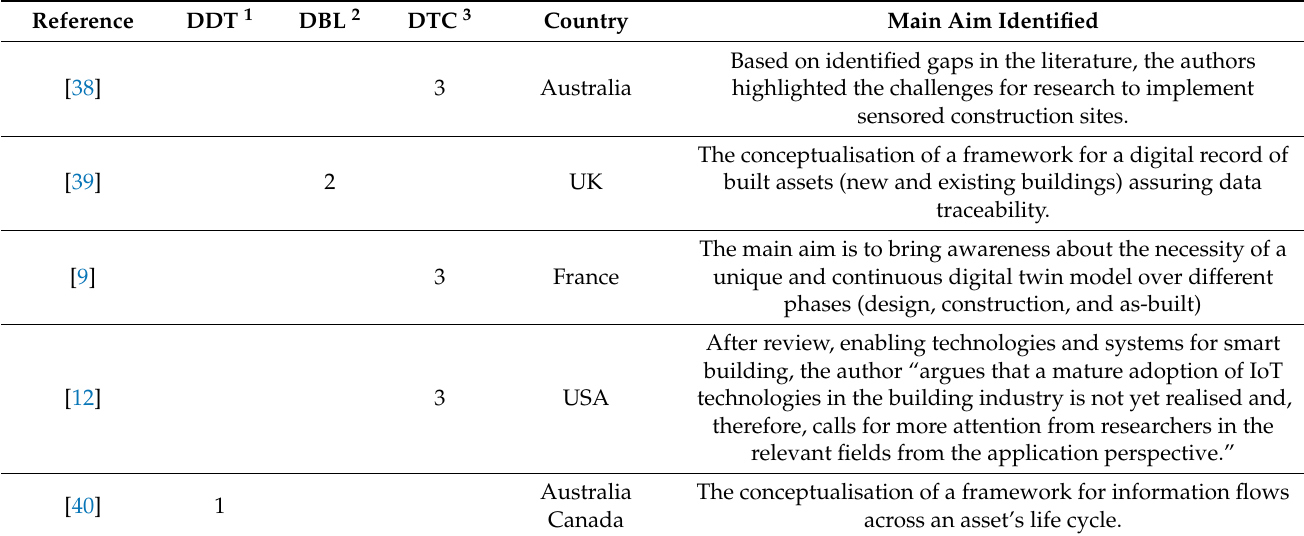
Table 3. The content of the selected articles and theses (selected by the authors), in terms of digital solutions implemented (DDT—digital data templates—1; DBL—digital building logbook—2; DTC—digital twin construction—3) and the main research aims